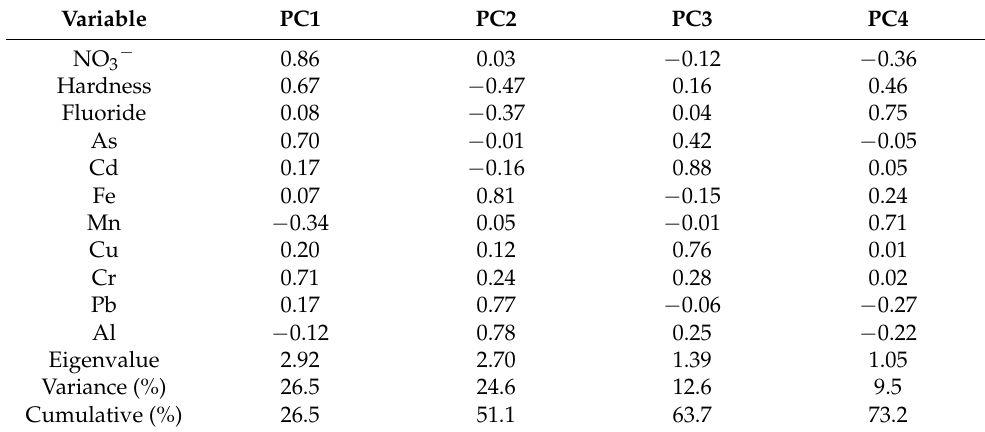
Table 1. Component matrix and explained variance (principal component analysis (PCA)) for groundwater quality